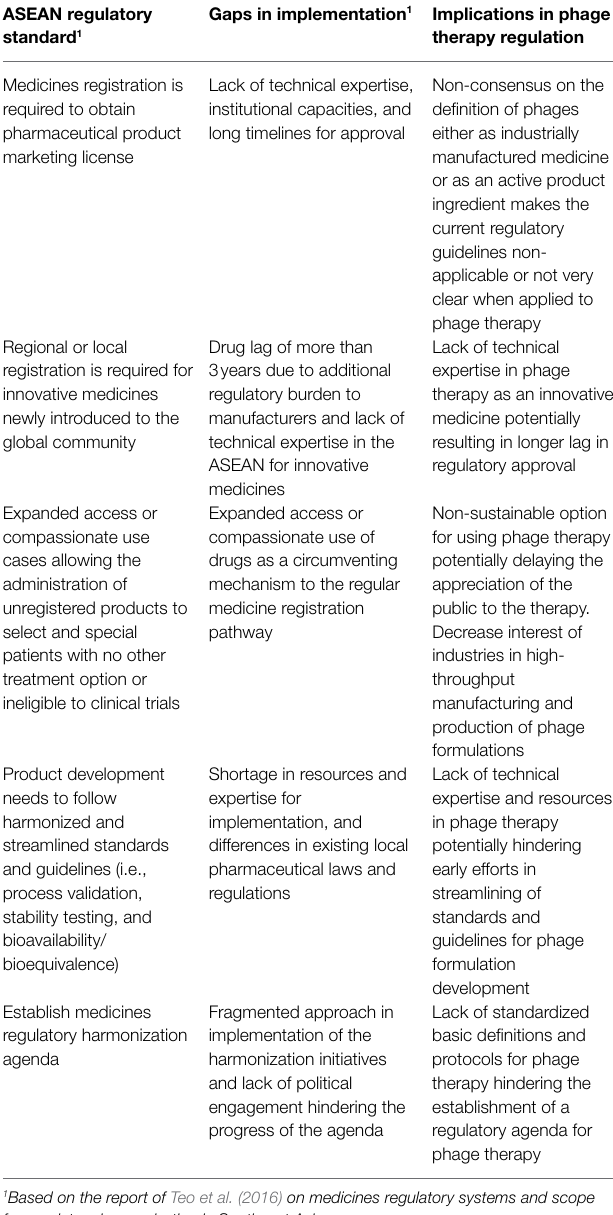
TABLE 4 | Existing regulatory standards with potential implications in phage therapy implementation in SEA. ASEAN regulatory standard